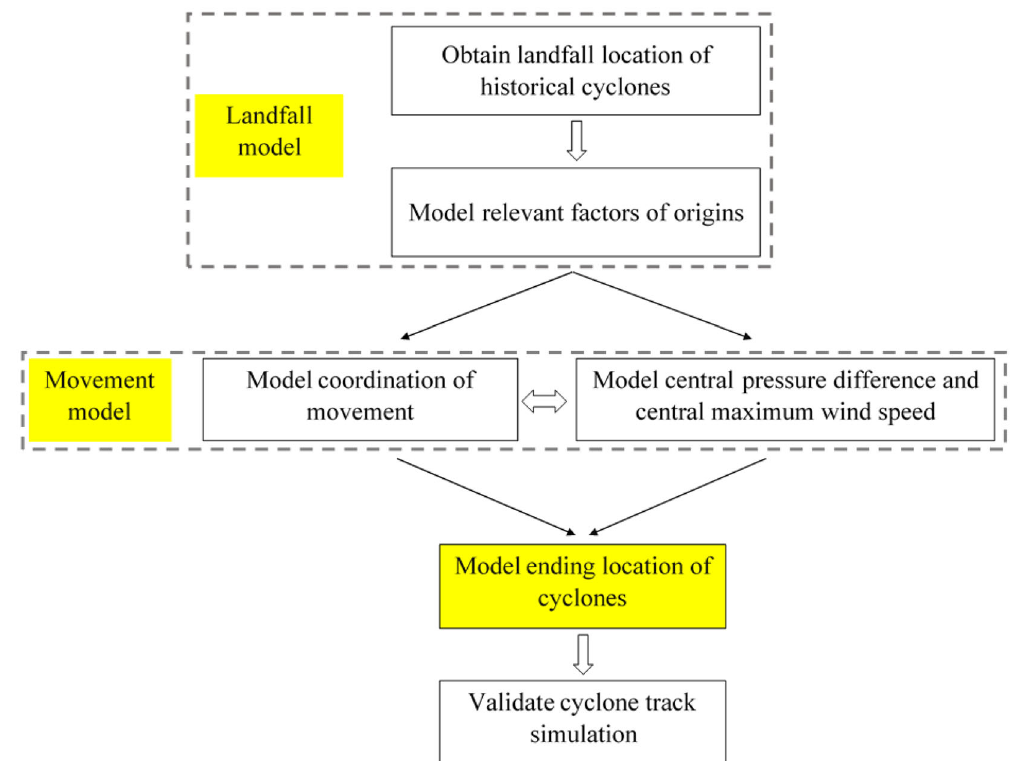
Fig. 2 Process of cyclone track modeling